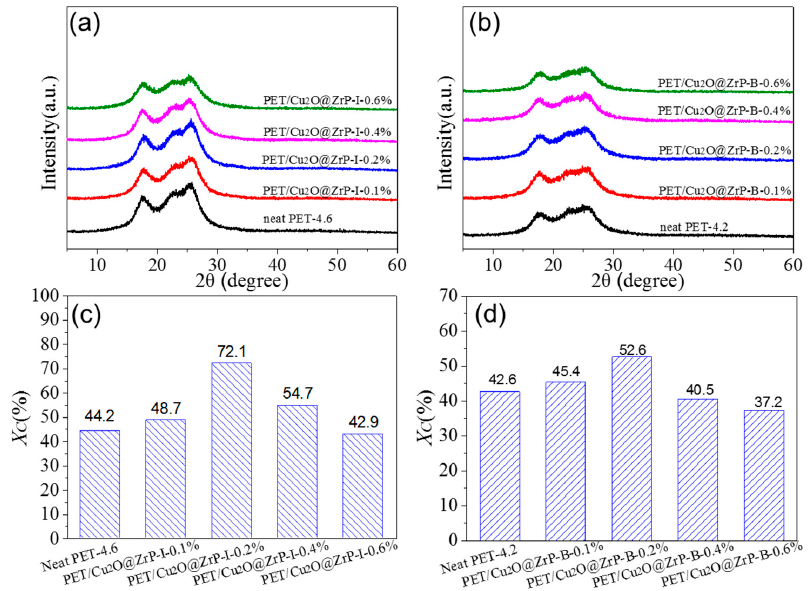
Figure 5. XRD curves of PET/Cu 2 O@ZrP-I and PET/Cu 2 O@ZrP-B ( a , b ) drawn fibers and ( c , d ) crystalline.